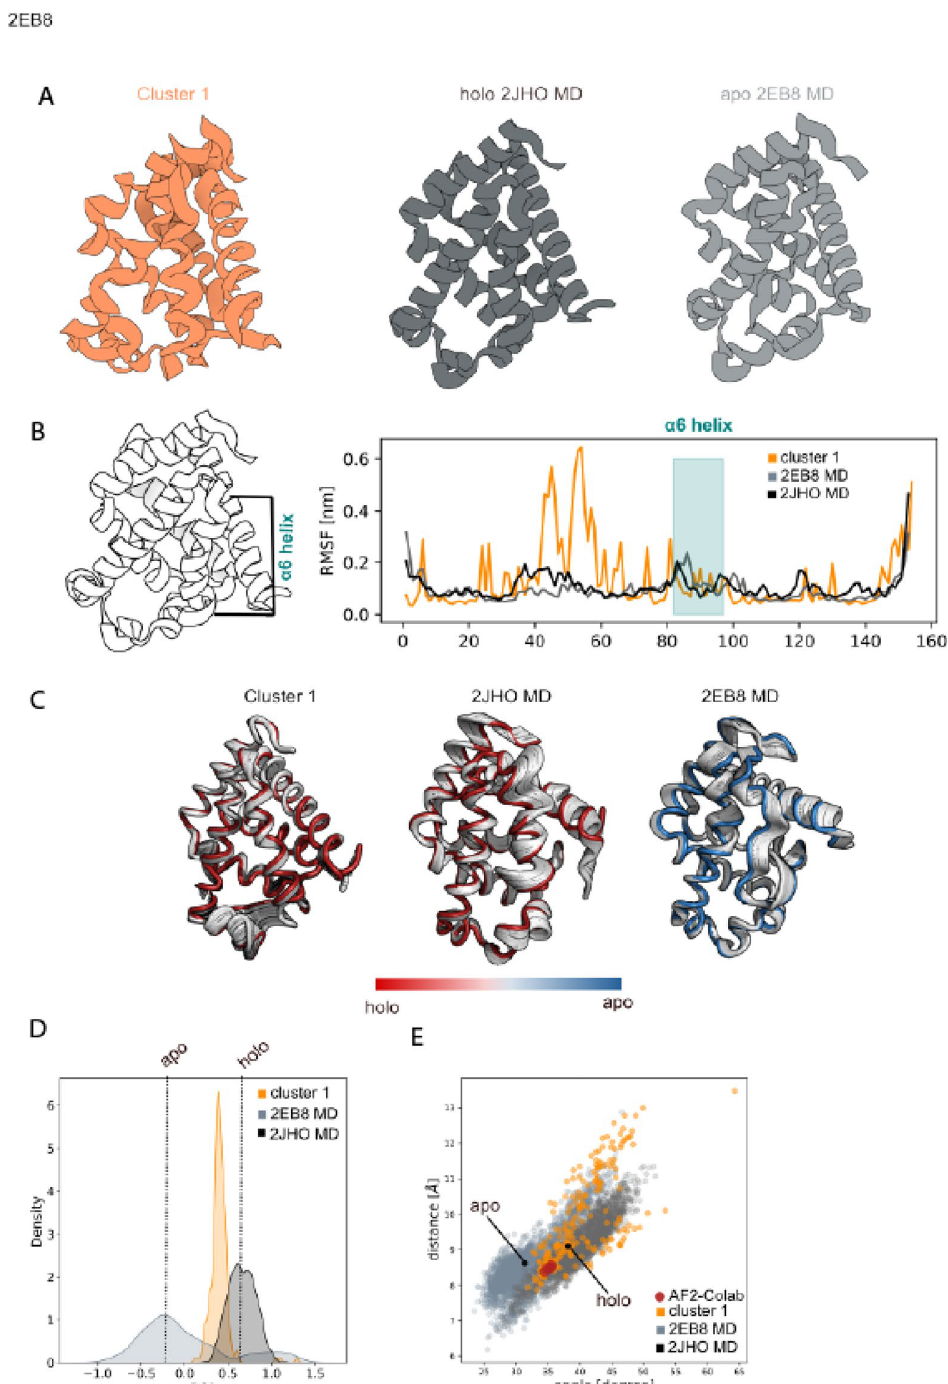
Figure 3. Myoglobin protein. ( A ) Cartoon representation of the cluster centroid (orange), 2JH0-MD snapshot (dark-grey) and 2EB8-MD snapshot (light-gray); ( B ) Root Mean Square Fluctuation (RMSF) analysis showed the cluster rigidity α6-helix regions (orange) comparable to the holo 2JH0-MD conformation (dark-grey); ( C ). Principal Component Analysis for the cluster and MD simulations highlighted the protein internal movement showing the cluster low flexibility compatible with the 2JH0-MD simulation; ( D ). First principal component density distribution plot for 2JH0-MD (dark-grey), 2EB8-MD (light-gray) and cluster-1 (orange) unveiled that the cluster internal movement explored is compatible with the 2JH0-MD simulation; ( E ). distance/angle correlation analysis of cluster-1 (orange) overlaps with the conformational space explored by both the holo 2JH0-MD and apo 2EB8-MD (dark-gray). AlphaFold2 prediction from EMBL-DB was not public available. Google Colab predictions are reported as red spheres and explored intermediate states. The closed and open X-ray αI-domains of LFA-1 conformations are specified with a black dot. The images were generated using 3D protein imaging webserver (https:// 3dpro teini maging. com/ prote in-